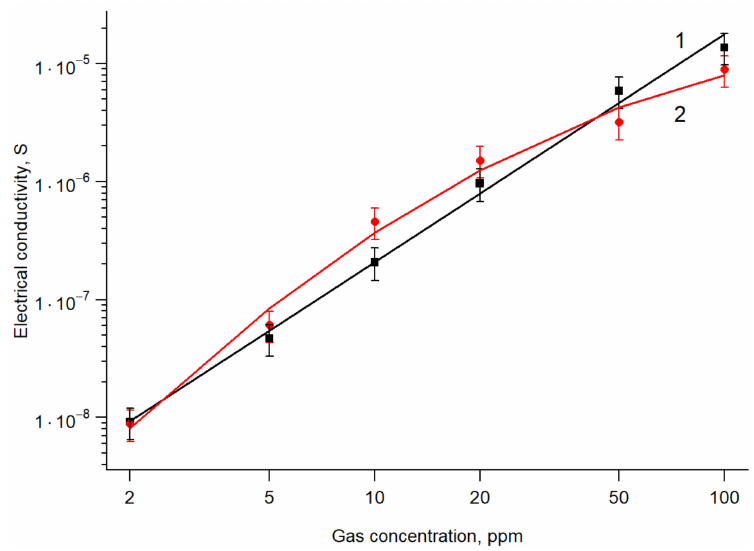
Figure 5. Calibration curves of the SnO 2 –PdO x sensor when determining hydrogen (curve 1) and carbon monoxide (curve